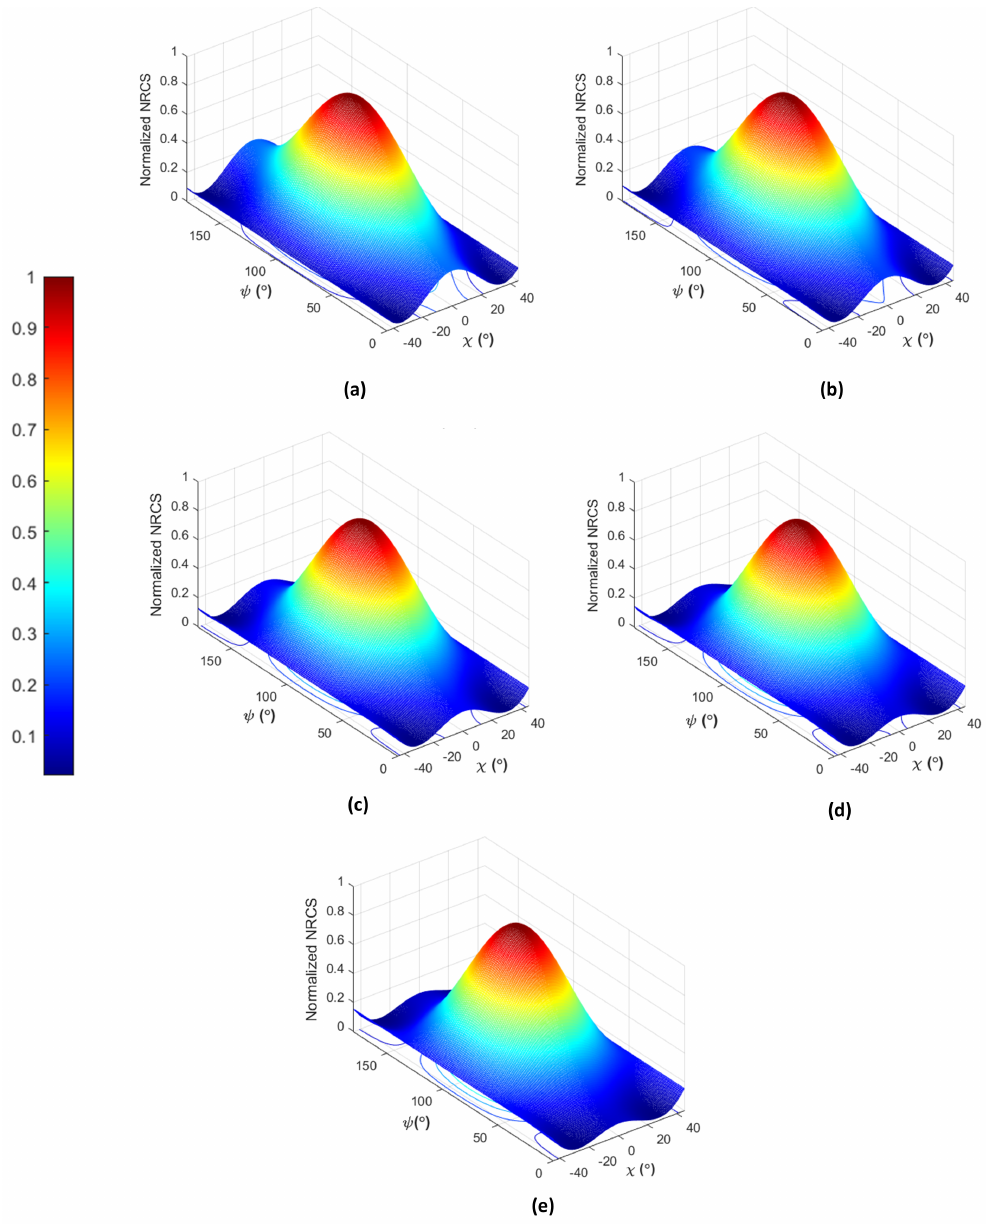
Figure 11. Normalised co–polarisation signature evaluated over the sea surface ROI at: ( a ) AOI = 35.7 ◦ , ( b ) AOI = 38.5 ◦ , ( c ) AOI = 41.5 ◦ , ( d ) AOI = 45 ◦ , ( e ) AOI = 48.3 ◦